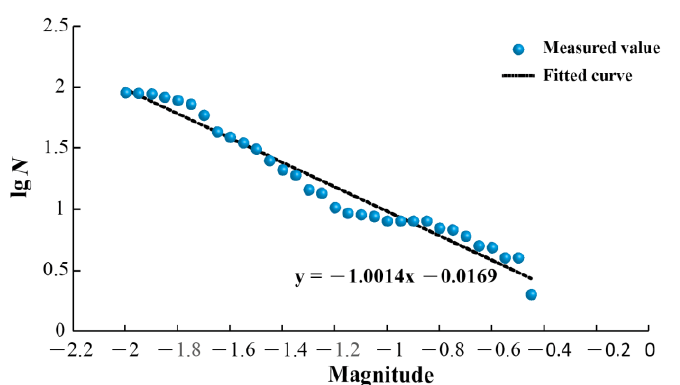
Figure 9. Relationship between magnitude and frequency of microseismic events (20 October 2020 to 10 December 2020).